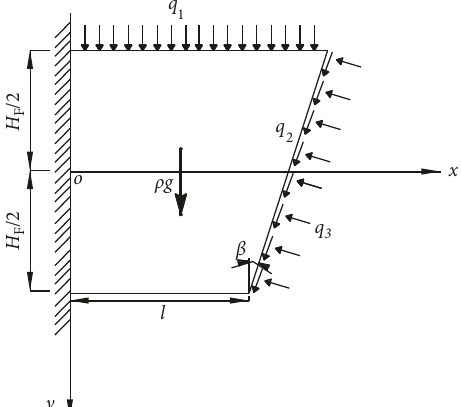
Figure 3: Theoretical model stress analysis of short beam under roof